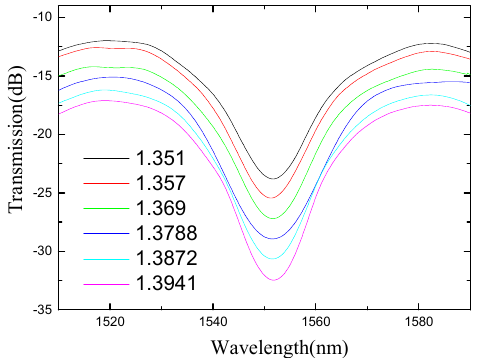
Micromachines 2022 , 13 , 658 Figure 8. The spectra under different ambient refractive indices. Figure 8. The spectra under different ambient refractive indices.